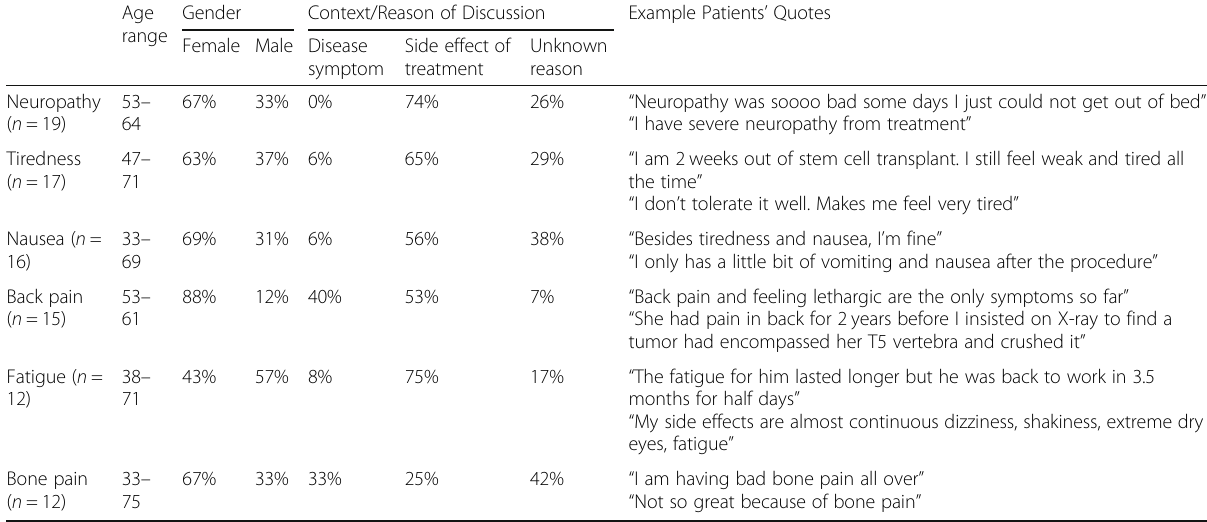
Table 1 Most Commonly Reported Symptoms Age Gender Context/Reason of Discussion Example Patients ’ range